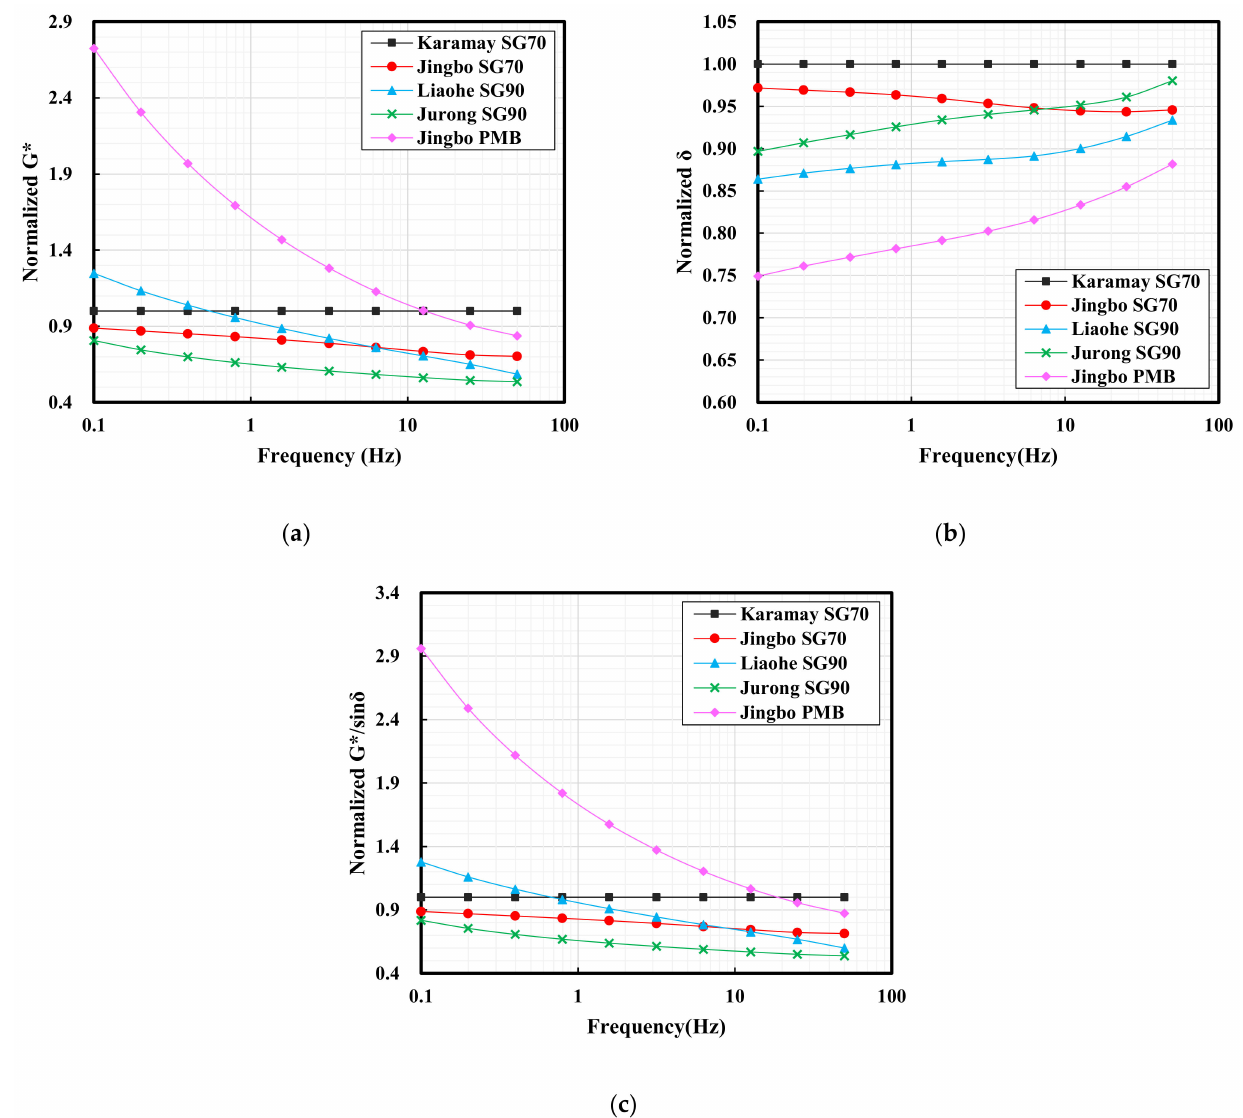
Figure 3. The normalized complex modulus ( a ), phase angle ( b ) and G*/sin δ ( c ) of five hydraulic bitumen binders at 70 ◦